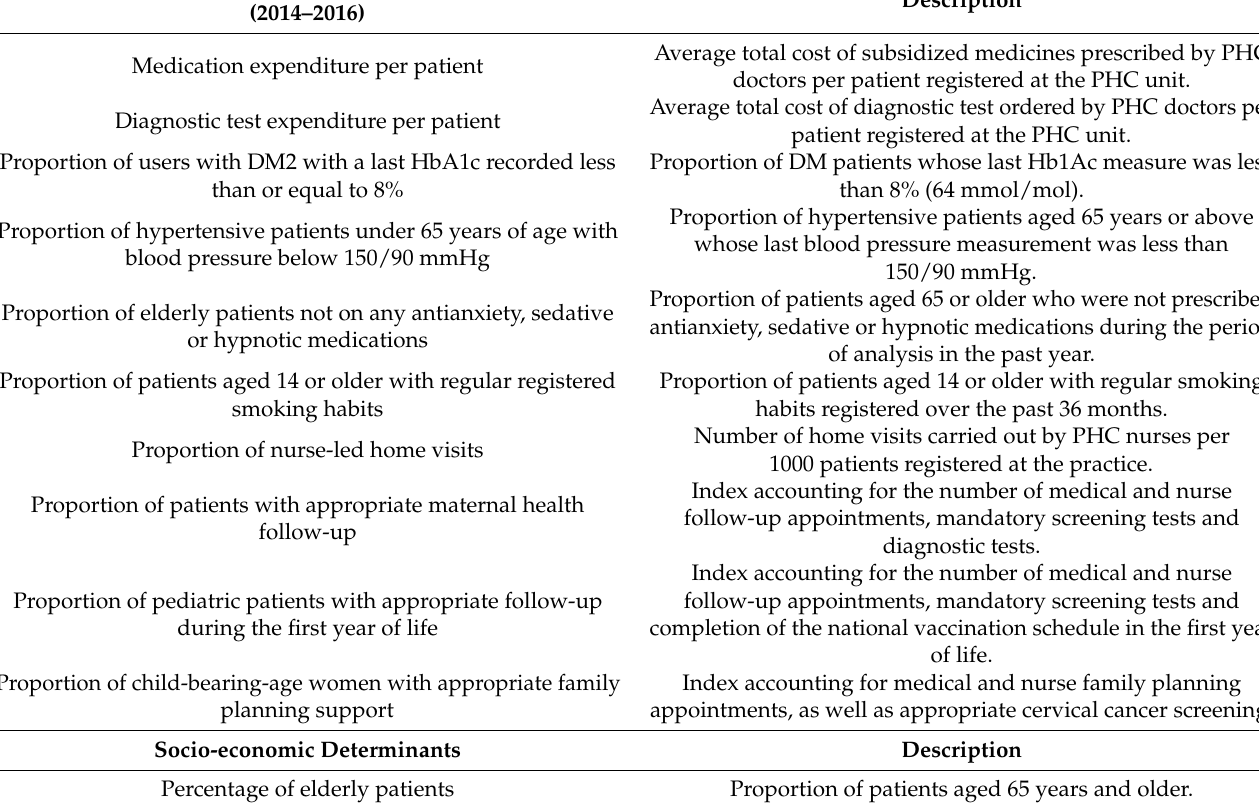
Table 1. Description of commissioning indicators for Portuguese PHC units (2014–2016), socio- economic determinants analyzed and Portuguese PHC type of